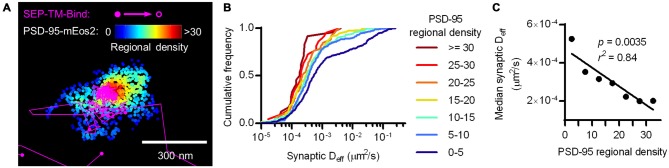
Nanoscale regional density of PSD-95 within the synapse correlates with probe diffusion coefficient. (A) Typical example of tracks and PSD-95 positions. Tracks pseudo-colored purple, PSD-95 positions pseudo-colored by regional density. (B) Cumulative frequency distributions of probe Deff binned in increasing regional densites of PSD-95 surrounding the subtracks (n = 448 subtracks in 0–5 PSD-95, 281 in 5–10, 159 in 10–15, 106 in 15–20, 59 in 20–25, 22 in 25–30, 24 in 30+). (C) PSD-95 regional density and the median Deff of the binding probe; relationship tested by linear regression.